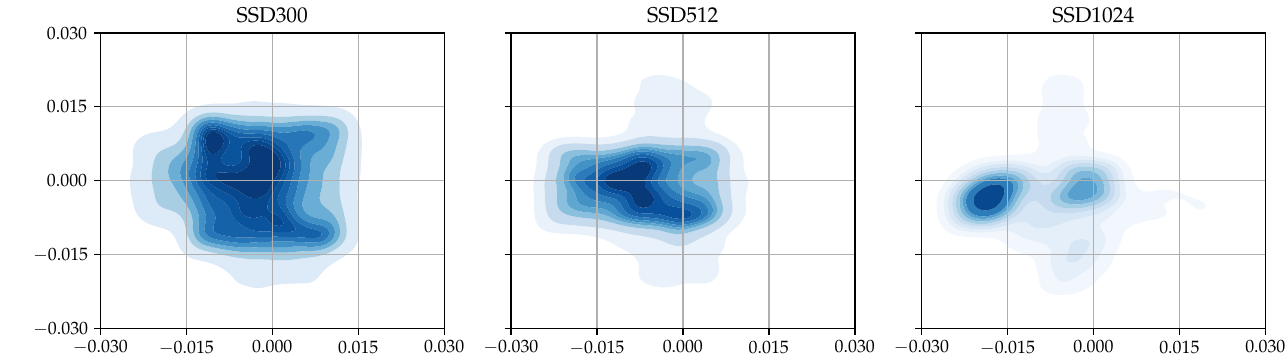
Figure 2. Relative center point distribution obtained from the TT100K dataset.